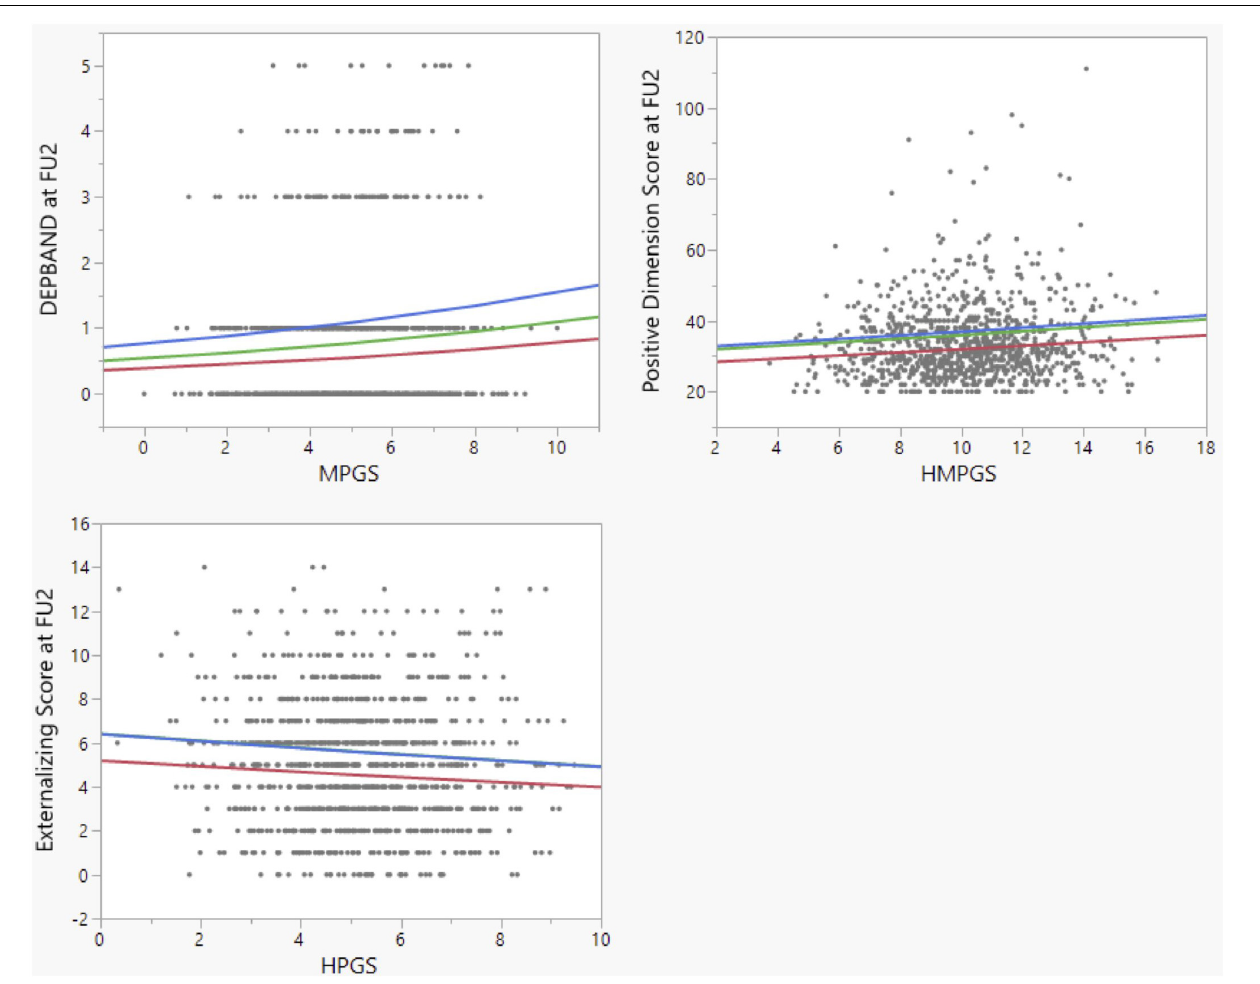
FIGURE 1 | Correlations between RRIs (determined from their link with GM regional volumes at age 14 as described in the text) and psychometric measurements at age 18. MPGS = MRRI, HPGS = HRRI, HMPGS = HMRRI. The colored lines are proposed regression lines for the different levels of childhood maltreatment (CM), after controlling for CM and sex. Red: CM = 0; green: CM = 1; blue: CM = 2. The blue and green line overlap in the bottom left graph.